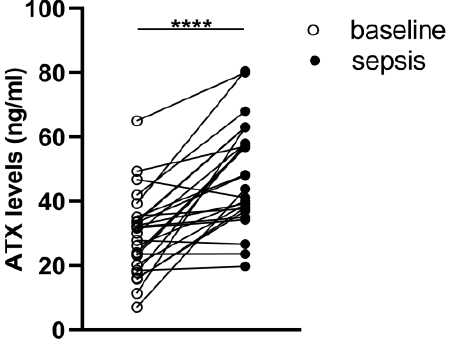
Figure 5. Increased ATX concentrations in patients with sepsis in comparison to their baseline levels ≤24 h after ICU admission. ATX levels were measured using a commercially available ELISA assay. Statistical significance was assessed with the Wilcoxon signed rank test for paired data analysis. **** denotes p < 0.0001.